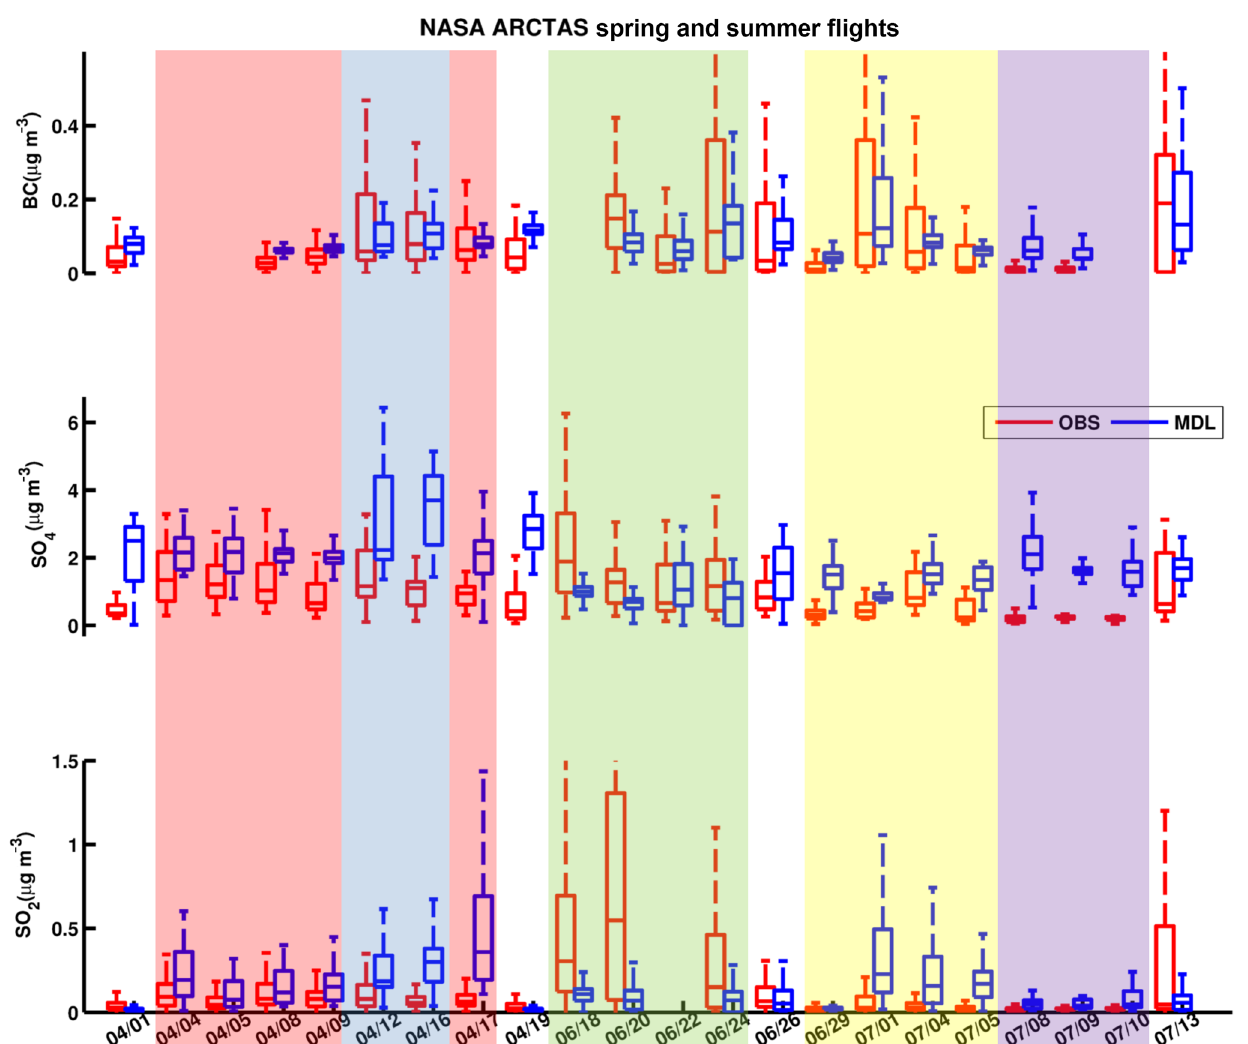
Figure 3. Comparison of BC, sulfate (SO 4 ), and SO 2 for NASA Arctic Research of the Composition of the Troposphere from Aircraft and Satellites (ARCTAS) spring and summer flights. Each flight category is shaded with a different color, and the spring and summer transition flights are not shaded. Spring Alaska local flights and spring Greenland flights are shaded blue and red, respectively. Green, yellow, and purple shades denote the summer California flights, summer Canada flights, and summer Canada–Greenland flights. In each box-and-whisker plot, the middle line denotes the median value, while the edges of the box represent 25th and 75th percentile values, respectively. The whiskers denote the maximum and minimum